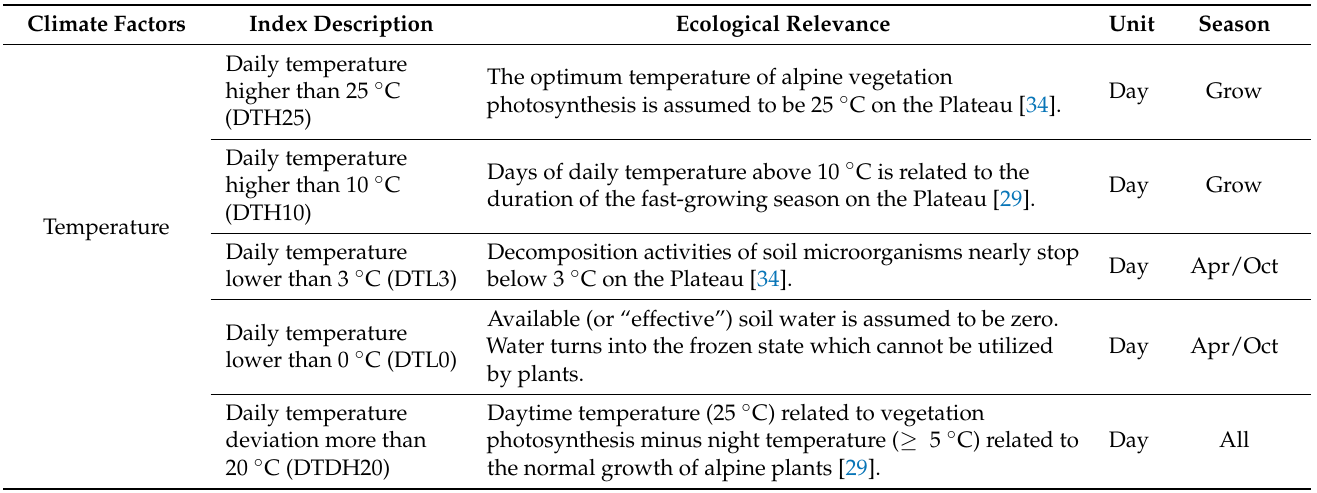
Figure 2. Definitions of climate metric indices with ecological relevance and indices of extreme climate events based on climatic variables. The ranges of climate indices are constrained in the parts of the graph between the dashed lines. The conventional indices of extreme climate events have often been identified as far beyond the normal levels of the climate conditions, corresponding to distributional tails of climatic variables (10% or less). The climate indices with ecological relevance refer to the magnitudes of the climatic variables that cause dramatic changes (threshold behaviors) in the ecosystem variables. For the climate indices with ecological relevance, their distributions can also be narrower than those of the conventional indices of extreme climate events. The case in which sampling points constrained by climate indices with ecological relevance was not particularly demonstrated since these sampling points are also captured by conventional indices of extreme climate events. The distance between the red and gray dashed lines varies with different ecosystem variables and climatic variables. In this study, climate variables mainly refer to daily precipitation and temperature. Ecosystem variables were considered from different ecosystem components like vegetation and soil, and important processes like water and carbon cycle. Table 2. Temperature and precipitation metric indices with ecological